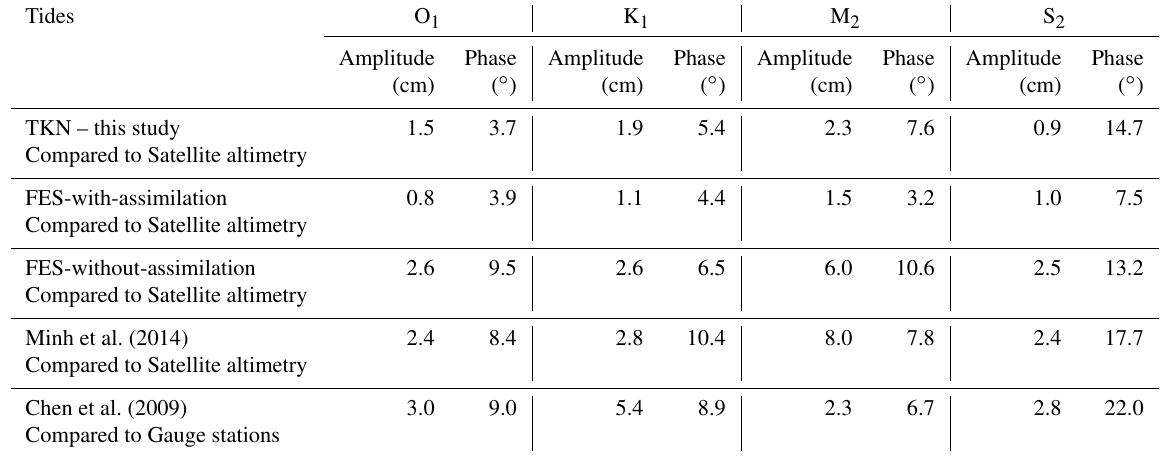
Table 2. Mean absolute differences (Appendix; Eq. A3) in amplitudes (in centimeters) and phase (in degrees) of M 2 , S 2 , O 1 , and K 1 constituents between our reference TKN and satellite altimetry. For comparison, the two FES products compared with satellite altimetry, the work of Minh et al. (2014) compared with satellite altimetry, and the work Chen et al. (2009) compared to gauge stations are presented. Tides O 1 K 1 M 2 S 2 Amplitude Phase Amplitude Phase Amplitude Phase Amplitude Phase (cm) ( ◦ ) (cm) ( ◦ ) (cm) ( ◦ ) (cm) ( ◦